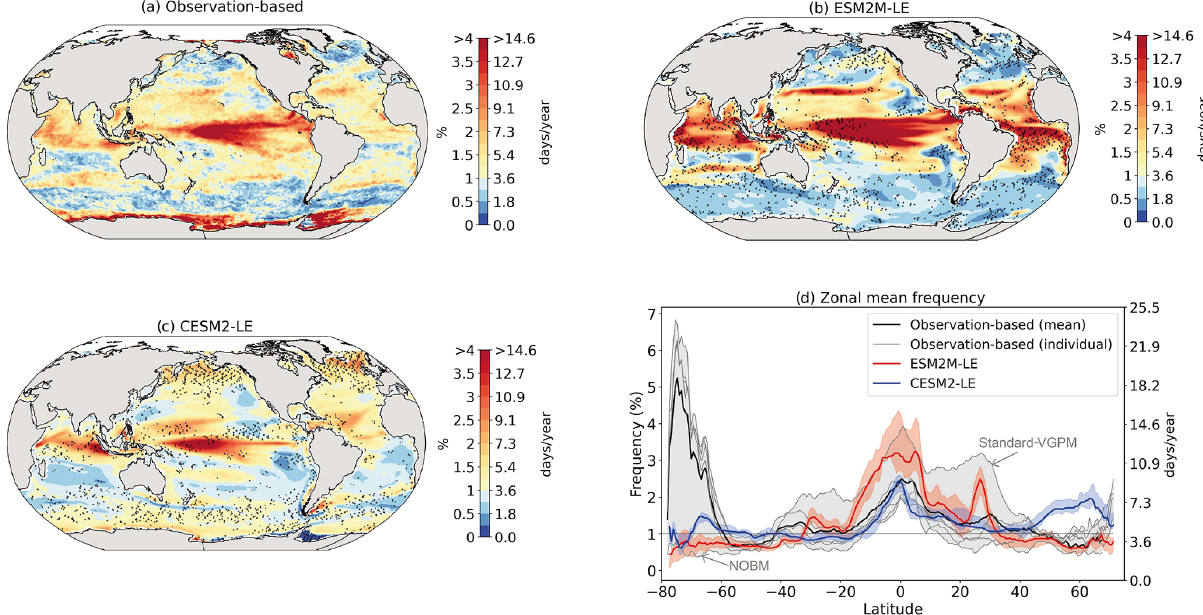
Figure 2. Frequency of compound MHW–NPPX events in (a) observation-based estimates and as simulated by (b) ESM2M-LE and (c) CESM2-LE. Observations correspond to the mean of the results obtained with five satellite-based estimates of NPP, namely NOBM, Standard VGPM, Eppley-VGPM, CbPM-VGPM, and CAFE-VGPM. (d) Zonal mean frequency of compound MHW–NPPX events. The gray-, red-, and blue-shaded areas in (d) indicate the range of the observation-based estimates, of the ESM2M-LE members, and of the CESM2-LE members, respectively. Stippling in (b) and (c) corresponds to regions where the frequency simulated by ESM2M-LE and CESM2-LE is outside the range of the observation-based estimates, i.e., higher or lower than all five observation-based